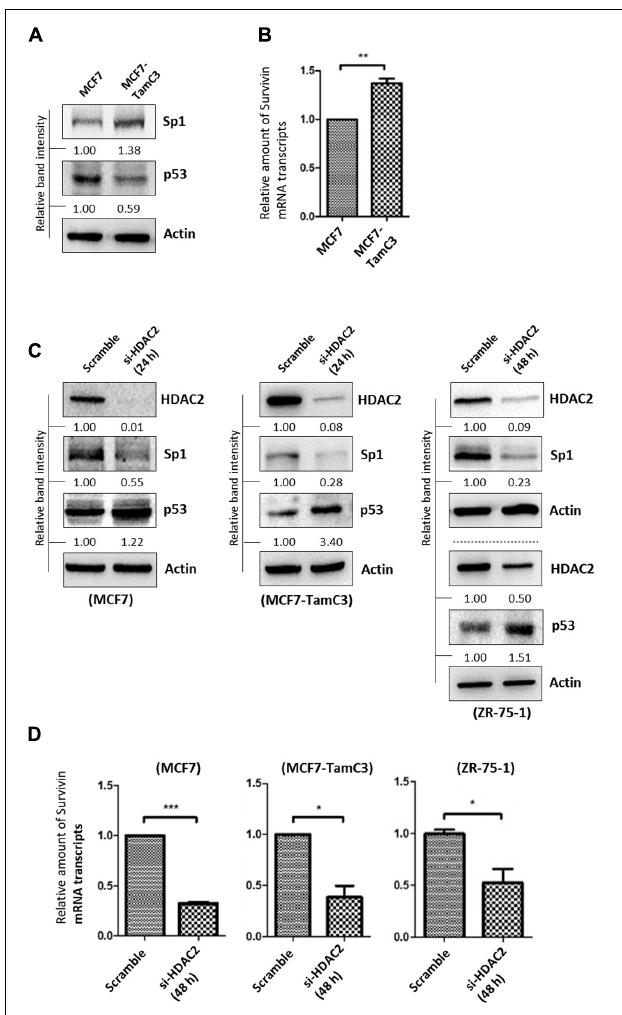
FIGURE 5 | HDAC2 positively regulates the expression of Sp1 and negatively regulates the expression of p53 in ER + breast cancer cells. (A) Expression of Sp1 and p53 in MCF7 and MCF7-TamC3 cells was determined by Western blotting. (B) Expression of survivin at the transcriptional level in MCF7 and MCF7-TamC3 cells was determined by qPCR. “ ∗∗ ” denotes a statistical significance ( P < 0.01) between the testing groups. (C) Breast cancer cells were transfected with either scramble siRNA or HDAC2 siRNA for 24–48 h (depending on the target knockdown efficiency in different cell lines). Expression of Sp1 and p53 was determined by Western blotting. (D) Breast cancer cells were transfected with either scramble siRNA or HDAC2 siRNA for 48 h and expression of survivin was determined by qPCR. “ ∗ ” and ∗∗∗ ” denote a statistical significance ( P < 0.05 and P < 0.001, respectively) between the testing